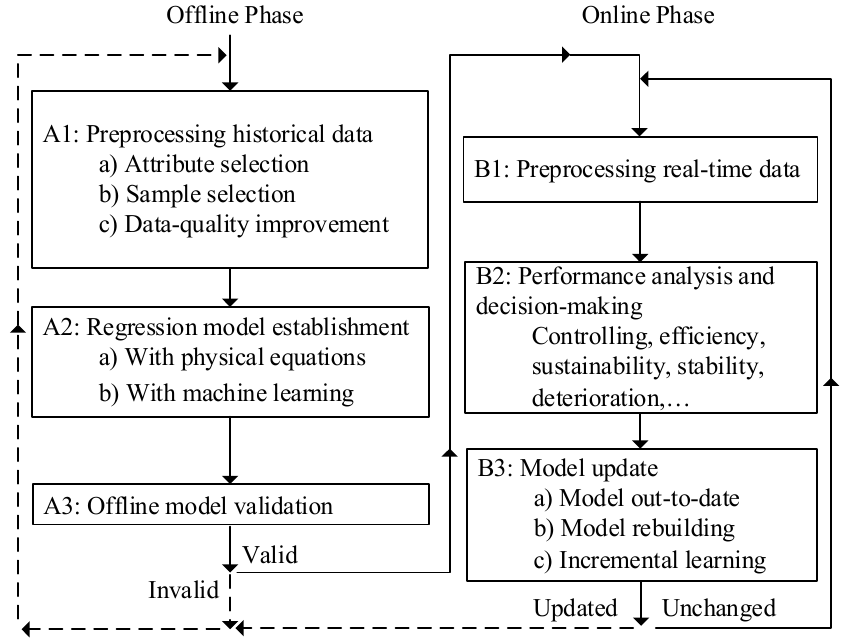
Figure 2. The procedure to establish a data-driven model based on the concept of cyber physical systems